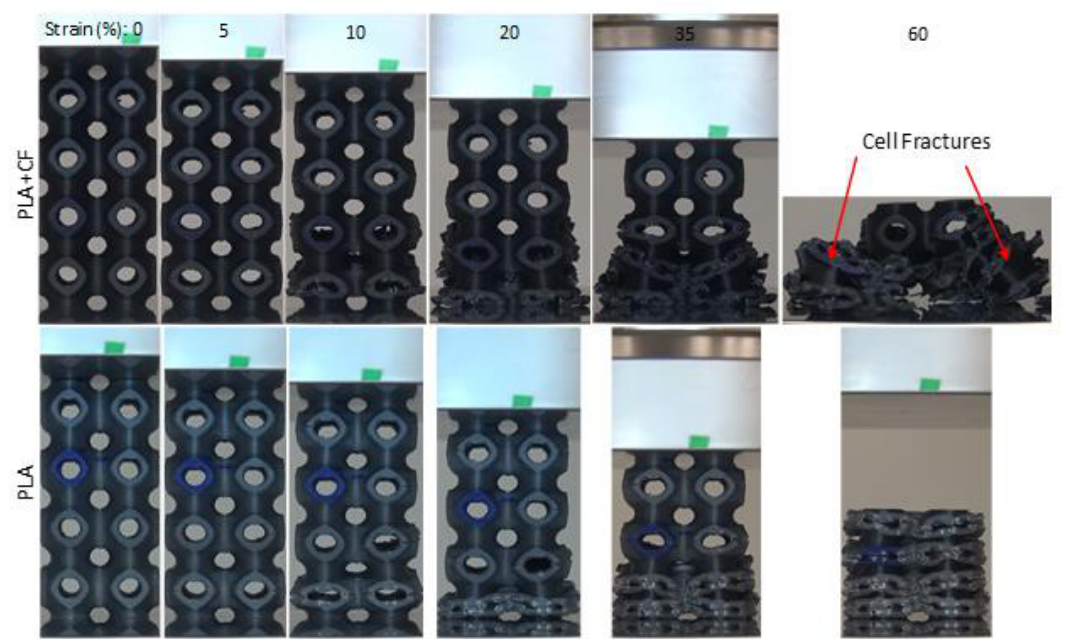
Figure 13. PLA + CF and PLA Primitive structures (P-12-30) deformation.